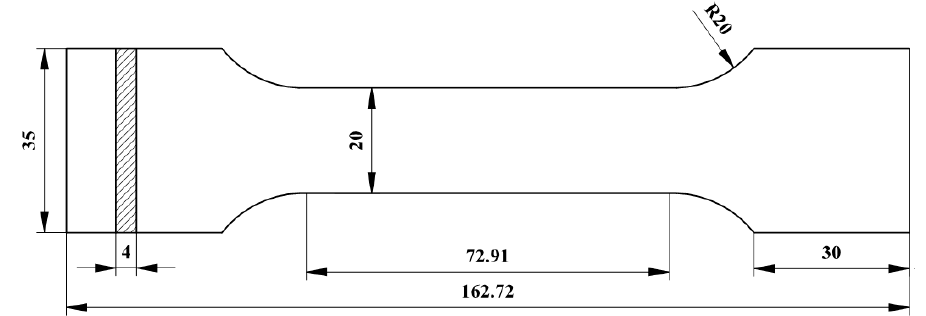
Figure 2. Dimensions of uniaxial tensile specimen (Unit: mm).